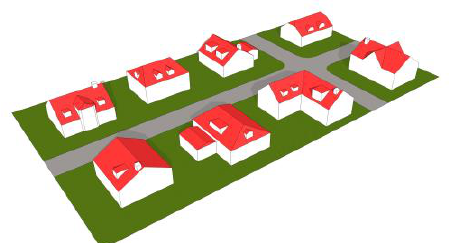
Figure 9. 3D example city model at LOD2